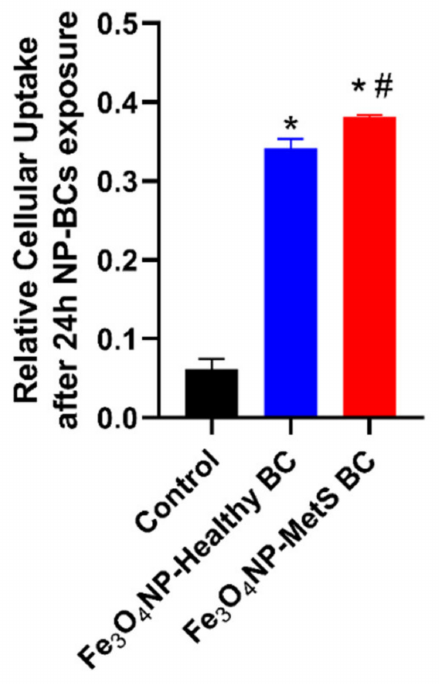
Figure 6. Measurement of cellular uptake of Fe 3 O 4 NP with BCs by XRF analyzer. Macrophages were exposed to 25 µ g/mL Fe 3 O 4 NPs with BCs for 24 h (n = 3/group). Cellular uptake of Fe 3 O 4 NPs was compared with untreated cells in SFM used as controls for the XRF analysis. * Denotes statistical significance compared to the expression of control group, # denotes statistical significance compared to the Fe 3 O 4 NPs with a healthy BC ( p < 0.05).